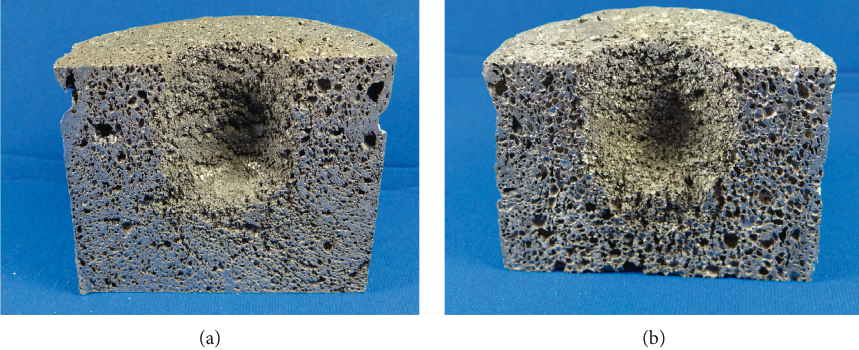
Figure 8: Cross-sectional view of indentations showing the deformed zone underneath the indenter: (a) Al foam F1; (b) Al foam